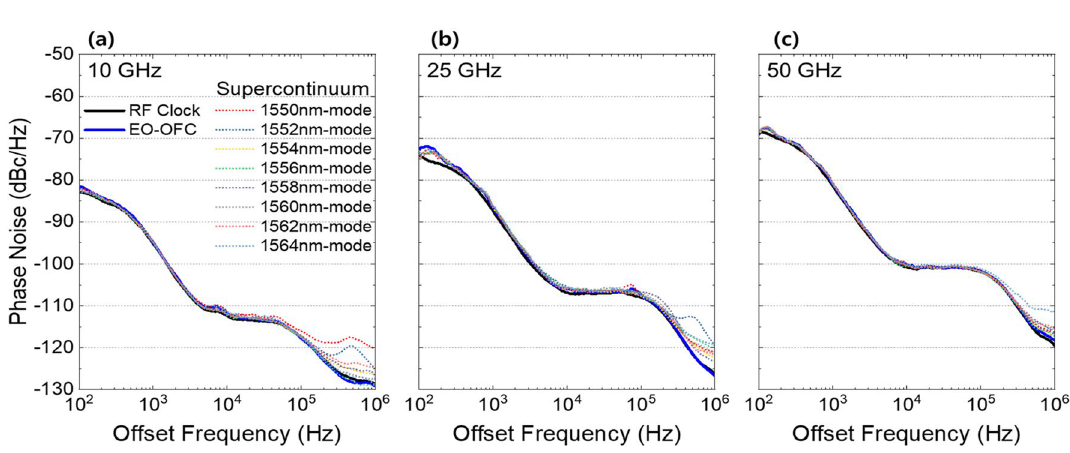
Figure 8. SSB RF spectrum-noise measurement at repetition rates of ( a ) 10, ( b ) 25, and ( c ) 50 GHz. The wavelength numbers of each mode show the shorter wavelength between the beaten